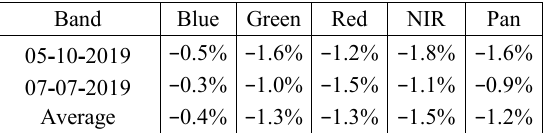
Table 5. Comparison of the convolved simulated TOA reflectance